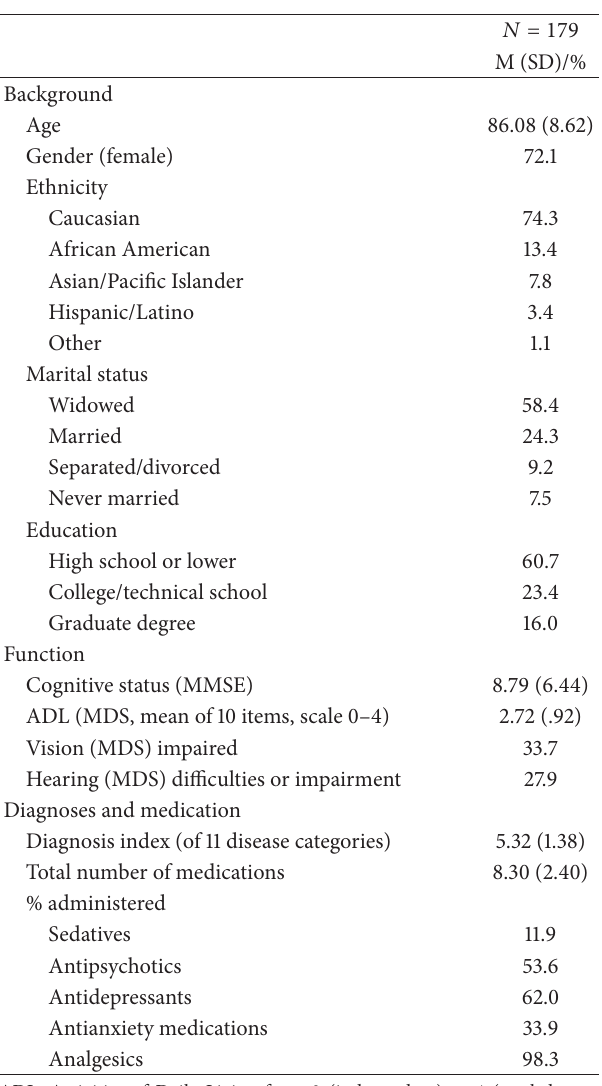
Table 1: Participants’